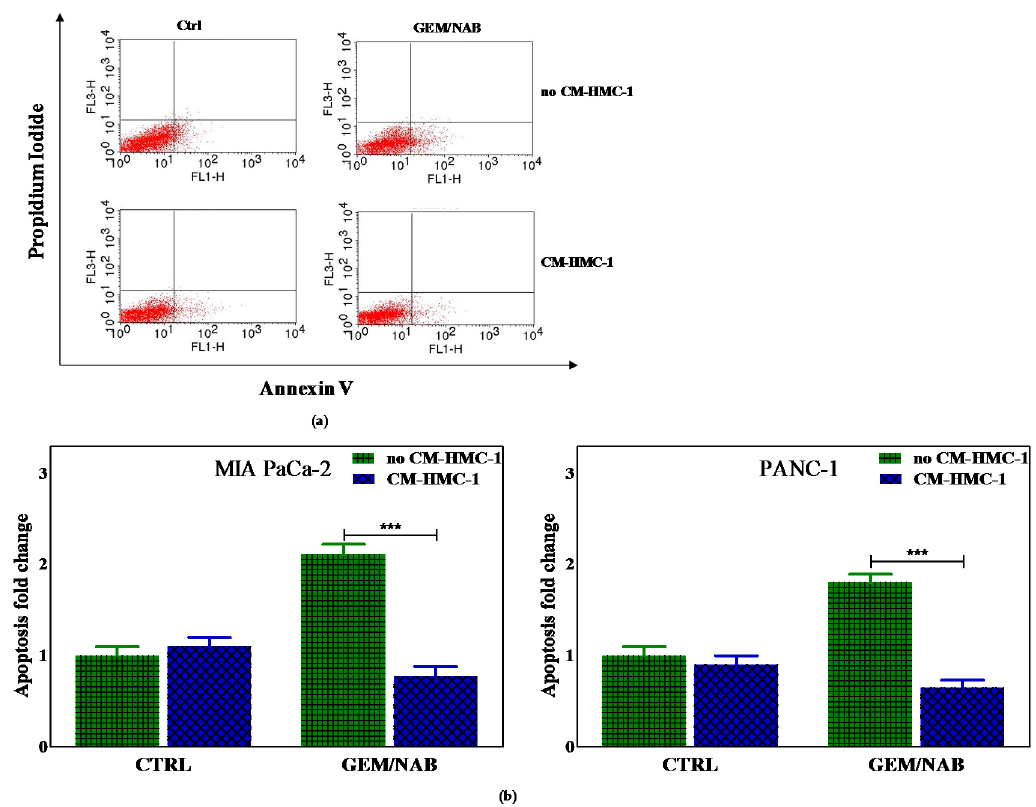
Figure 2. The effect of CM-HCM-1 on drug combination-induced apoptosis by the annexin V method. PANC-1 and MIA PaCa-2 were treated with drug combination with or without CM-HMC-1. After 24 h, the combination induced annexin V staining of tested cells but the apoptosis was completely blocked by the presence of CM-HCM-1. What is shown are ( a ) dot plots from experiments performed on MIA PaCa-2 cells and ( b ) graph bars reporting apoptosis quantification in MIA PaCa-2 and PANC-1 (*** p < 0.001).